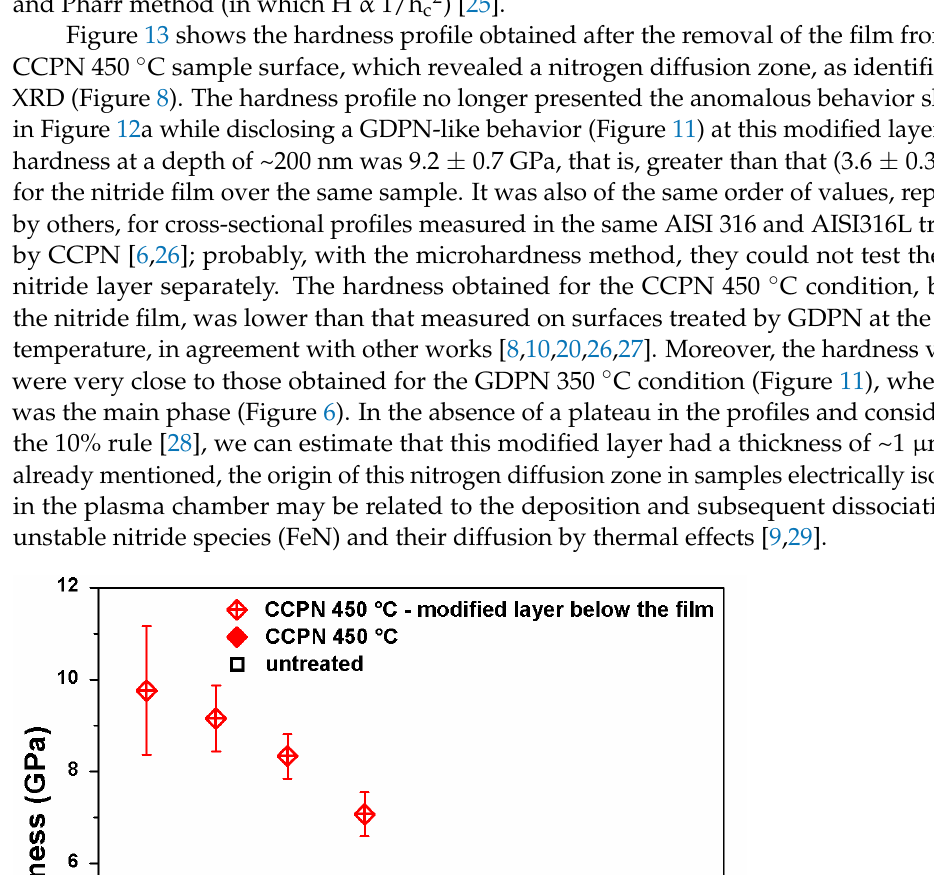
Figure 14. Nanoscratch profiles of untreated and GDPN-treated AISI 316 steel samples and micro- graphs obtained by backscattered SEM.